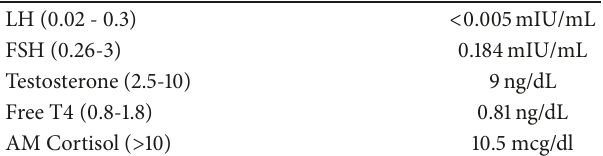
Table 1: Summary of initial endocrine hormones done at the age of 9 years and 4